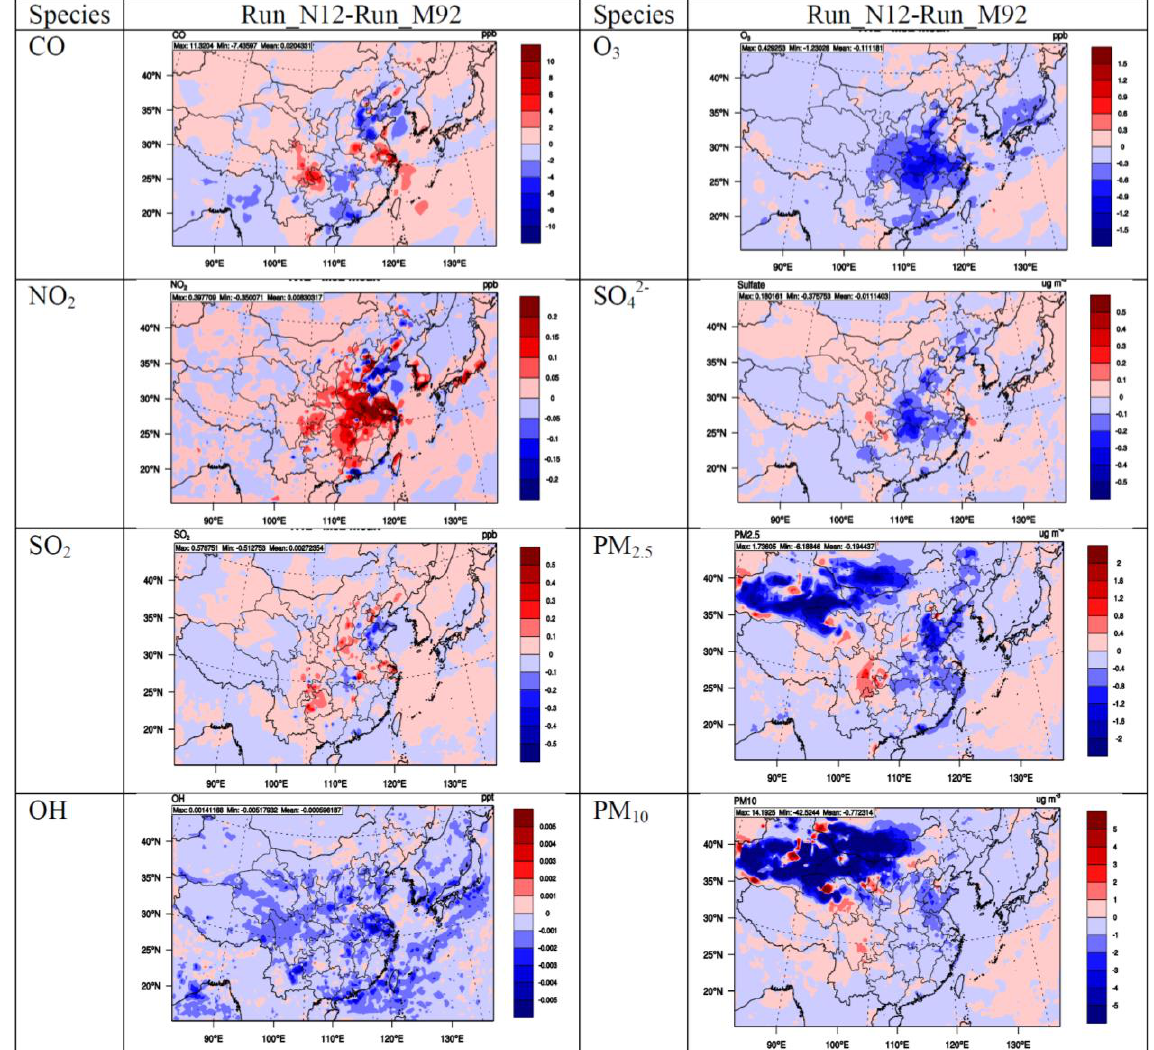
Figure 7. Absolute differences in the surface concentrations of chemical species between Run_N12 and Run_M92 for